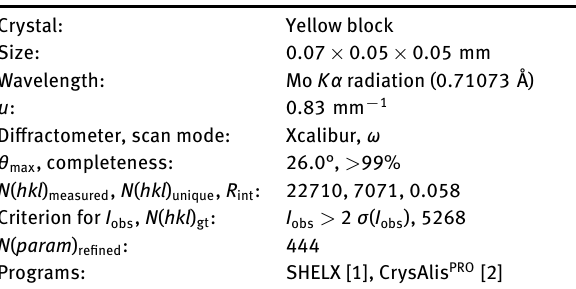
Table 1: Data collection and handling.